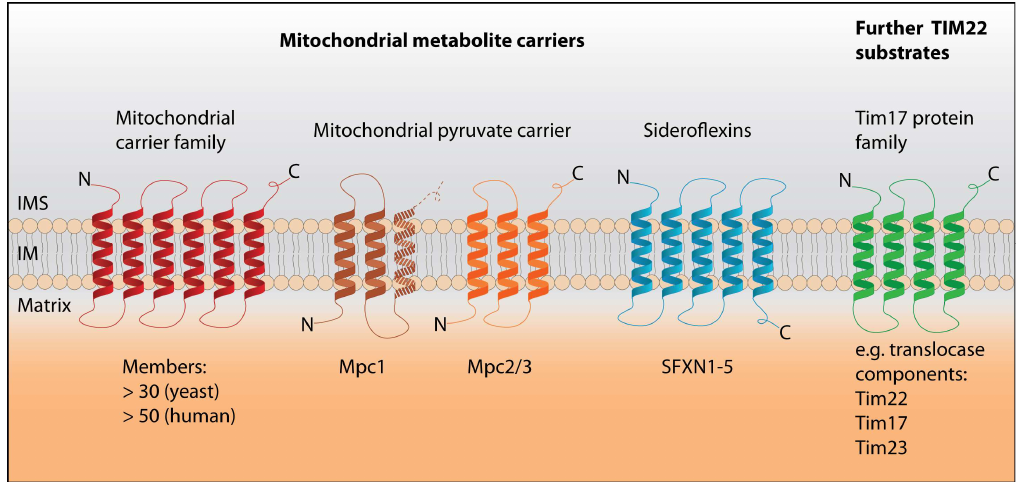
Figure 2. Substrates of the TIM22 carrier import pathway. Mitochondrial carriers of the mitochondrial carrier family (MCF)/SLC25 family ( red ), the components of the mitochondrial pyruvate carrier ( brown , orange ), as well as sideroflexins ( blue ) are imported into mitochondria via the TIM22 carrier pathway. MCF/SLC25 proteins have a uniform topology with 6 transmembrane segments [4,12,17,19,24]. In contrast, Mpc2/Mpc3 has only 3 TM segments, and Mpc1 has 2 or 3 TM segments [6,7,35–37]. The third unique family of metabolite carriers, the sideroflexins, has 5 TM domains with the N-terminus in the intermembrane space (IMS) [8,38,39]. Aside from metabolite carriers, the TIM22 pathway also and Tim23 ( green ). IMS, intermembrane space; IM, inner